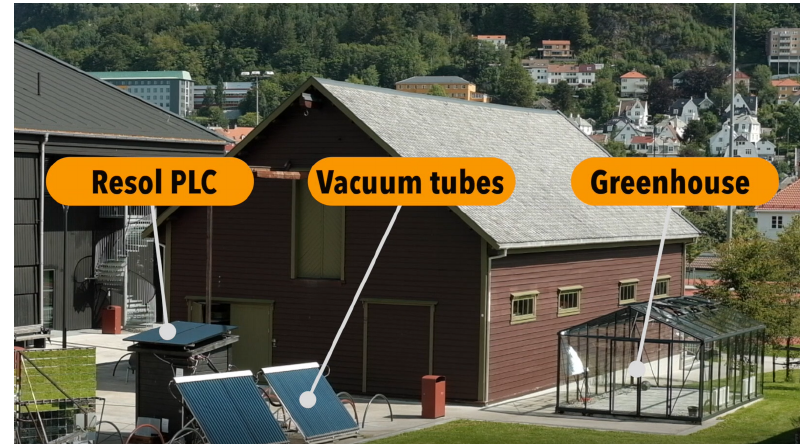
Figure 1. Vacuum tubes in the solar field of Høgskulen på Vestlandet.